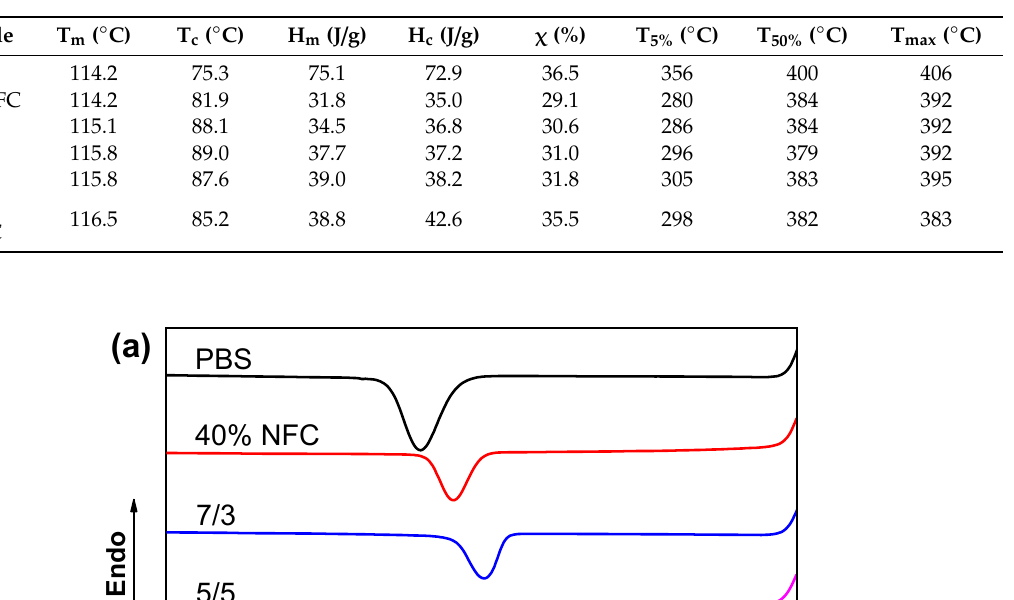
Table 3. Thermal properties of PBS / cellulose composites.